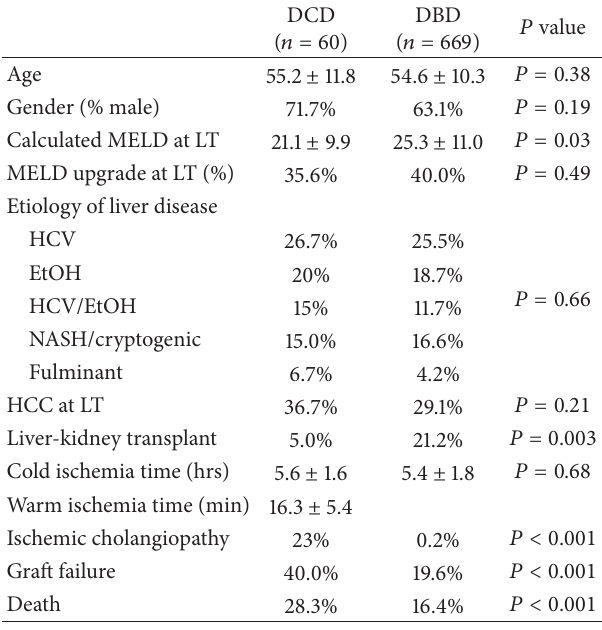
Table 1: Baseline characteristics of liver transplant